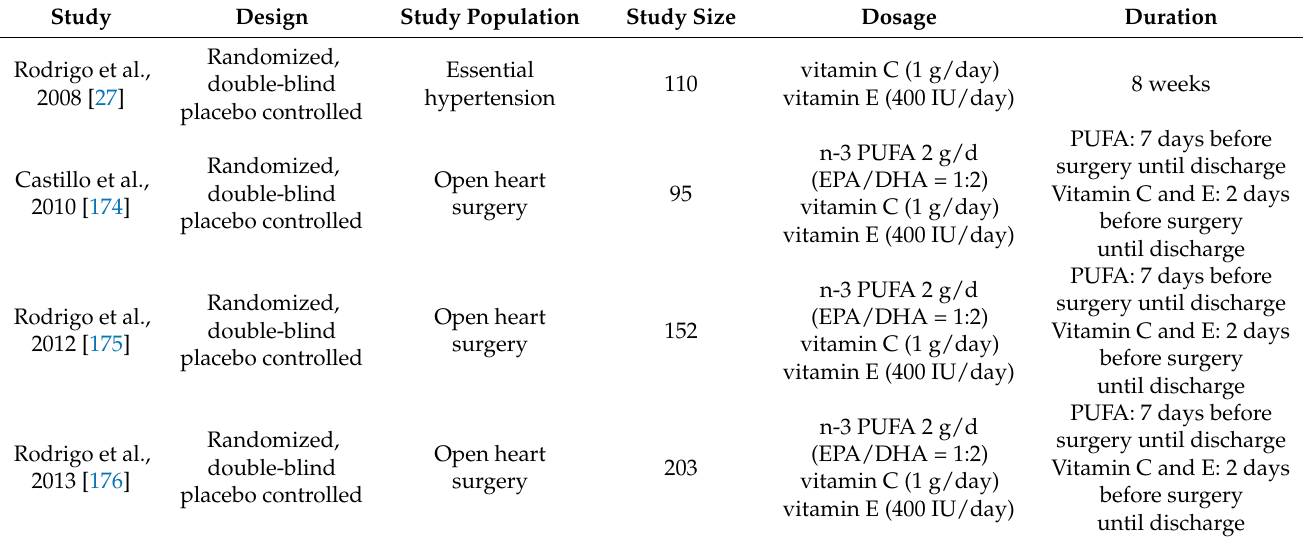
Table 2. Studies using a combined antioxidants